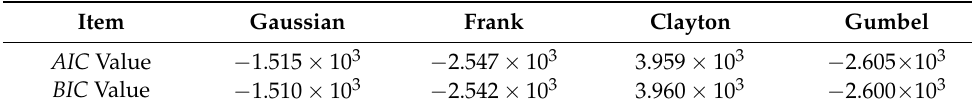
Table 12. AIC and BIC values for different copula types. The bold fonts generally indicate the lowest values in the table.